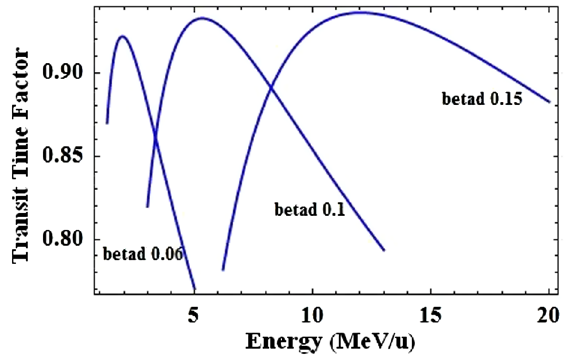
¼ 12 ) with phase g ¼ 2 g